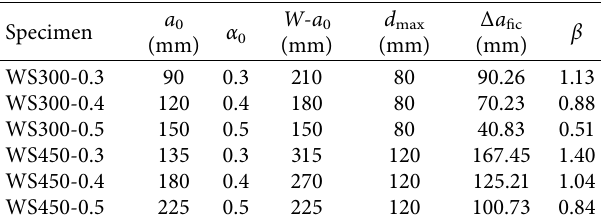
Table 3: Te efective crack length Δ a